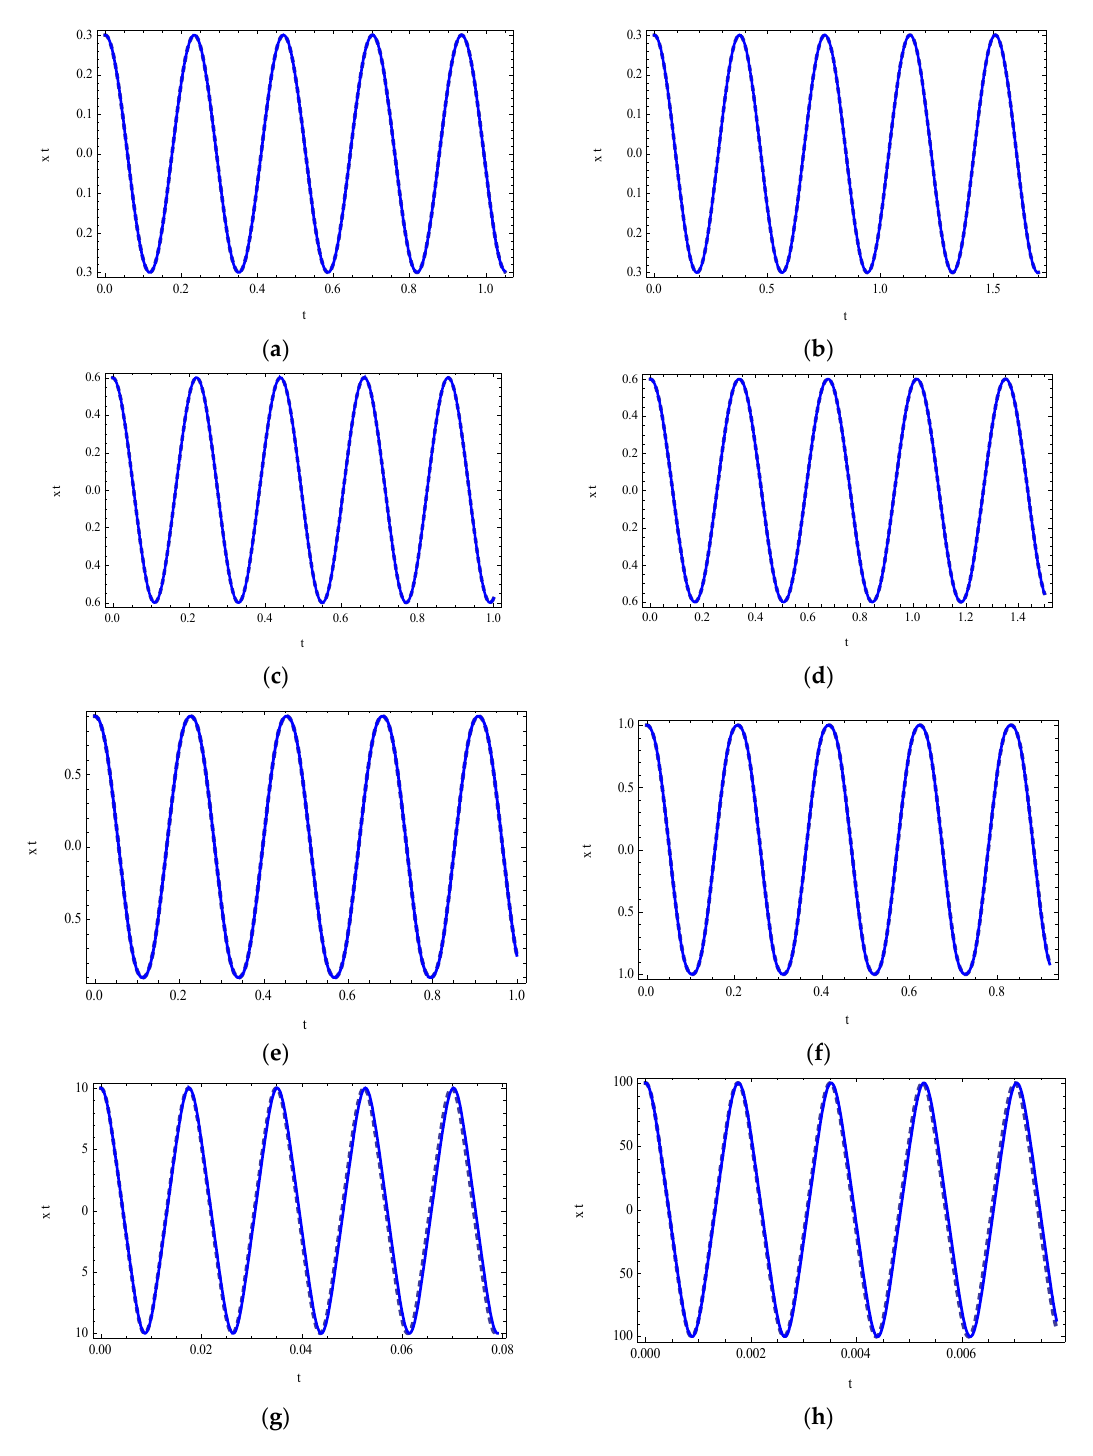
Figure 2. The comparison between analytical approximate solutions using the GRHBM (dashed line) and numerical solution (solid line). ( a ) A = 0.3, V = 0, N = 10, α = 24. ( b ) A = 0.3, V = 20, N = 10, α = 24. ( c ) A = 0.6, V = 10, N = 10, α = 24. ( d ) A = 0.6, V = 20, N = 10, α = 24. ( e ) A = 0.9, V = 10, N = 10, α = 24. ( f ) A = 1, V = 0, N = 10, α = 24. ( g ) A = 10, V = 10, N = 10, α = 24. ( h ) A = 100, V = 20, N = 10, α = 24.